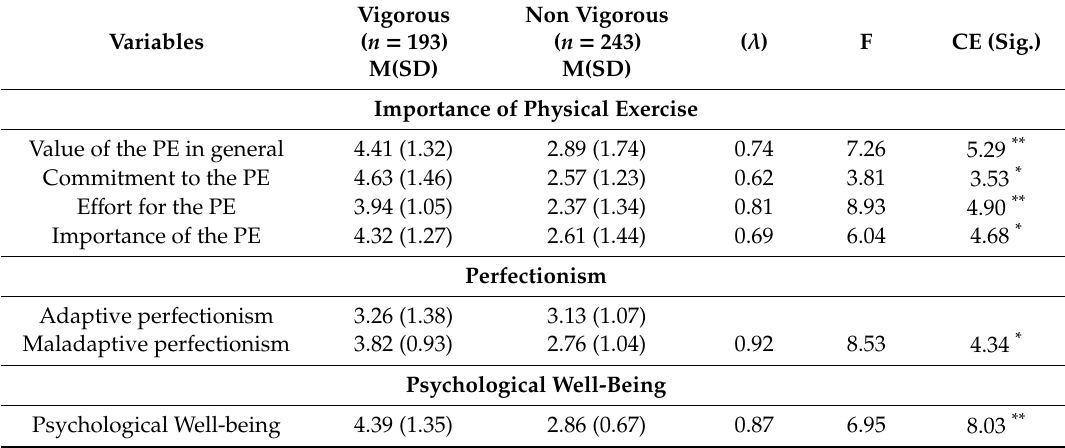
Table 2. Discriminant analysis according to the intensity of PA, perfectionism, and psychological well-being in a sample of adolescents.